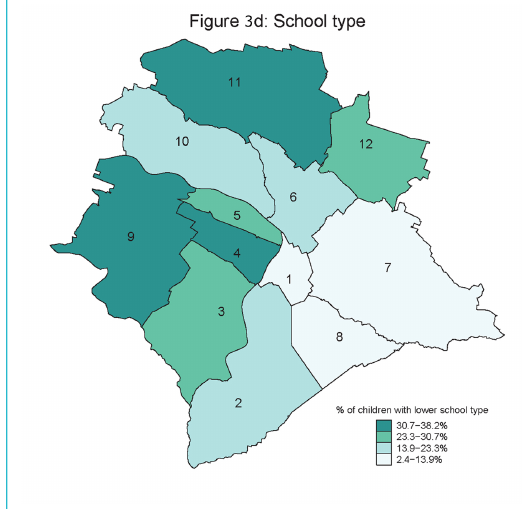
Figure 3d: Map of the City of Zurich showing the proportion of children with lower school type in different districts (intensity of the